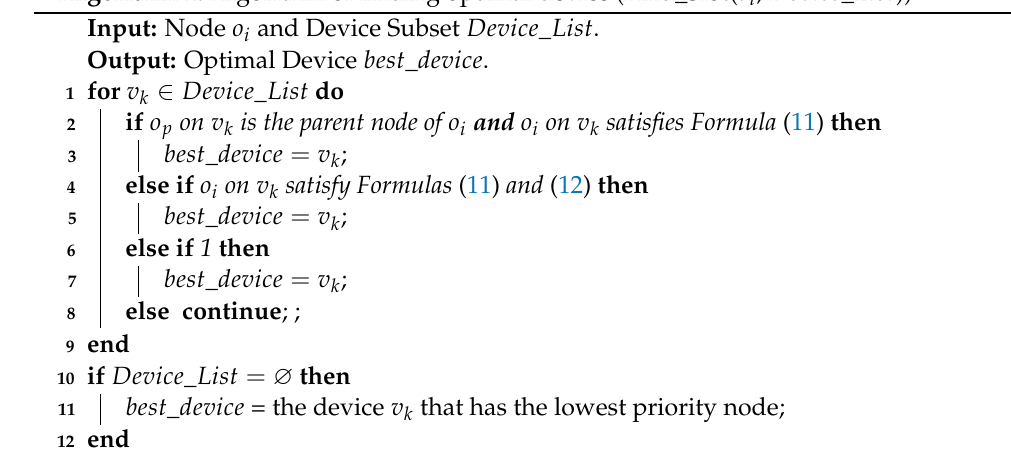
Algorithm 2: Algorithm of finding optimal device (Find_Slot( o i , Device _ List